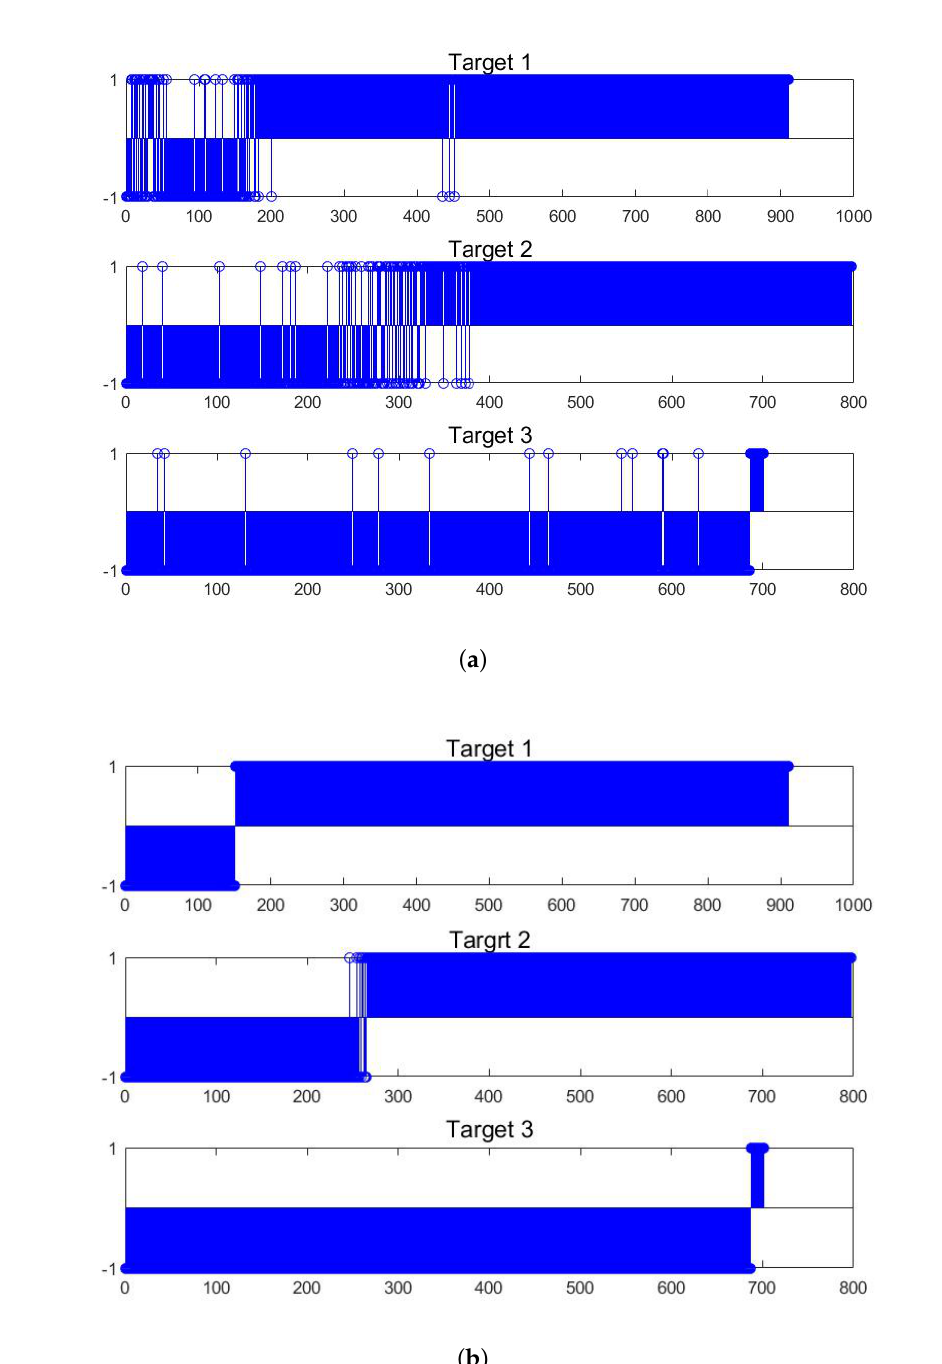
Figure 15. Detection results on Targets 1, 2, and 3 of Experiment 1 by using ( a ) SVDD and ( b ) the proposed method, where the label 1 and − 1 represent normal state and anomaly state,